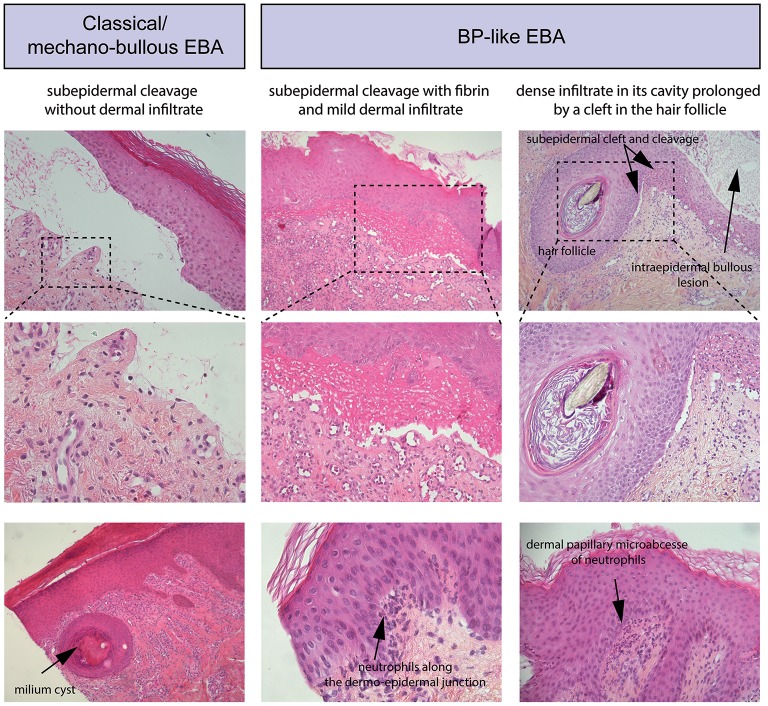
Standard histology. (Left) Histological study of lesional skin biopsies in a patient with a classical/mechanobullous form of EBA, subepidermal cleavage without dermal infiltrate; bottom, milium cyst in the dermis. (Middle) Patient with a BP-like form of EBA, subepidermal cleavage with fibrin in the blister cavity and mild dermal infiltrate. Bottom, Neutrophils along the dermo-epidermal junction (Right) Patient with a BP-like form of EBA, one intraepidermal bullous lesion and one subepidermal bullous lesion with dense infiltrate in its cavity prolonged by a cleft in the hair follicle; bottom, a dermal papillary microabcesse of neutrophils.